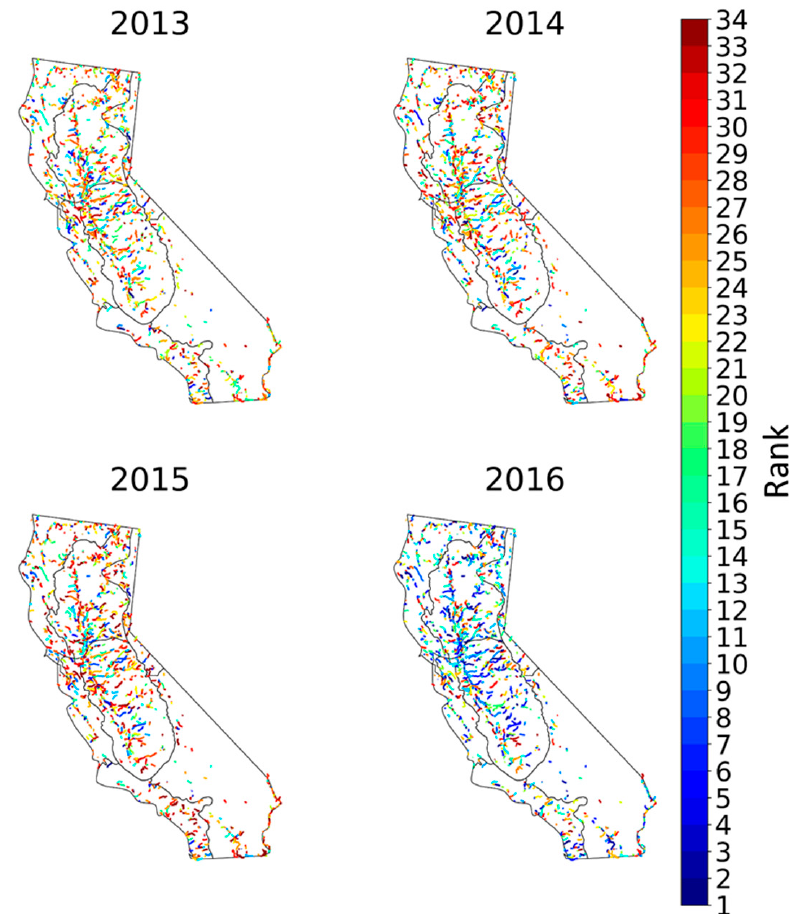
Figure 7. Ranks of annual mean FrcSA from high to low among 34 years of Landsat observation for 2071 river reaches in year 2014 to 2016. Ranks of 1 and 34 mean highest and lowest FrcSA during the 34 years, respectively.